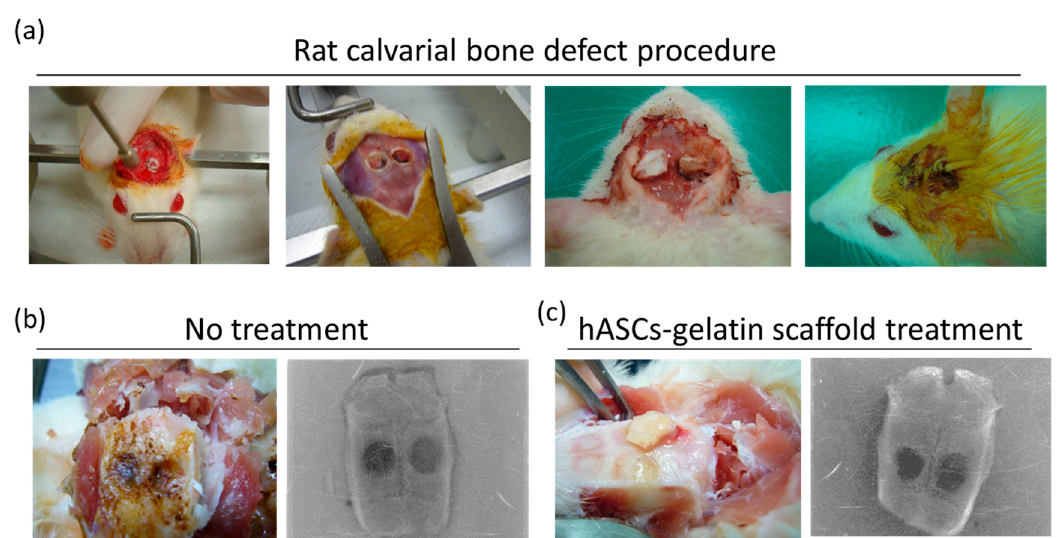
Figure 8. Rat model of calvarial bone defect. ( a ) Generation of the calvarial bone defect; ( b ) calvarial bone defect not treated with the hASC-gelatin scaffold at 12 weeks; ( c ) rat calvarial bone defect treated with the hASC-gelatin scaffold at 12 weeks of implantation.